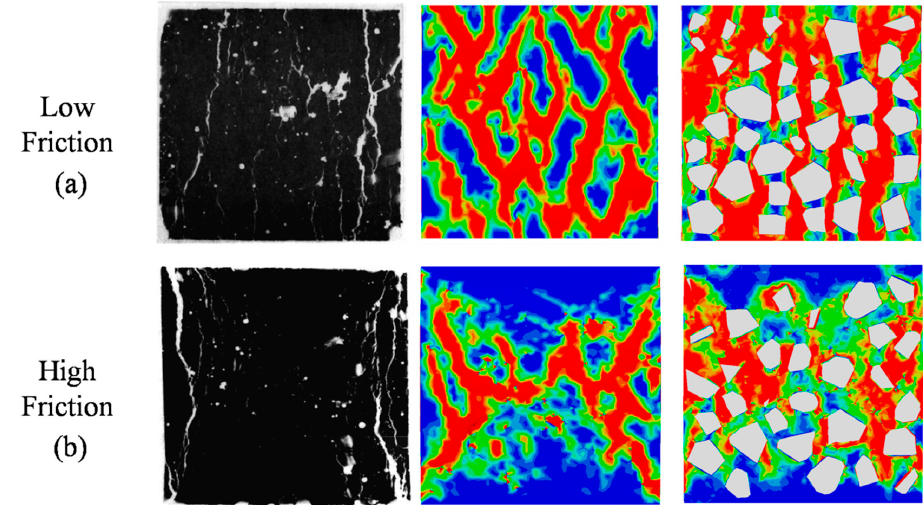
Figure 25. Comparison of failure patterns between experimental observations (left in each pair of graphs [56]) and numerical results (outer surface view and internal view): ( a ) Low friction condition, ( b ) high friction condition.